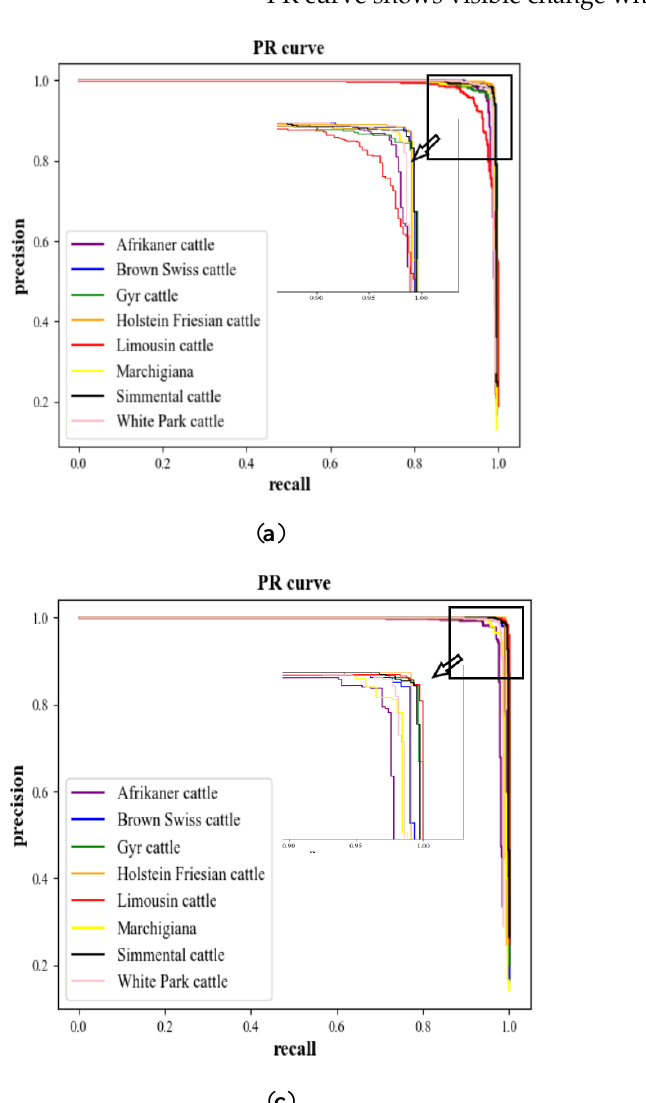
16 of 24 Figure 13. Sample of test images. Table 5. Sample comparison based on detection. Test Image Total No. of Objects No. of Positive Detections/Total No. of Detection